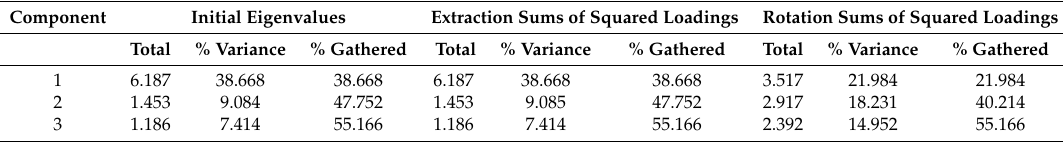
Table 9. Total explained variance. Extraction method: Principal component